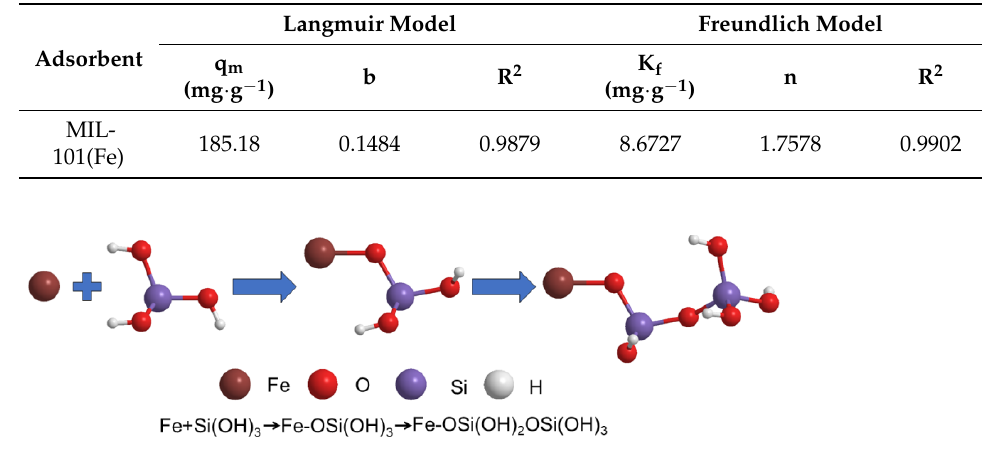
Figure 7. Chemical diagram involving the two-step mechanism. Table 2. Isotherm parameters of silicic acid adsorption process.